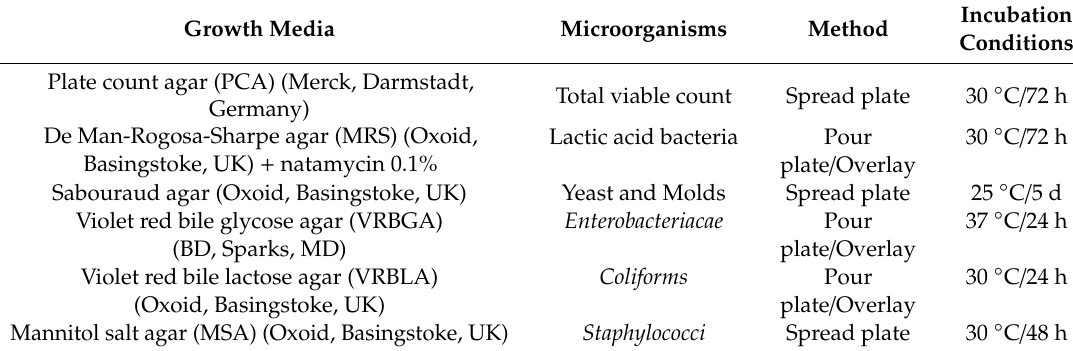
Table 1. Microbiological media used for microflora